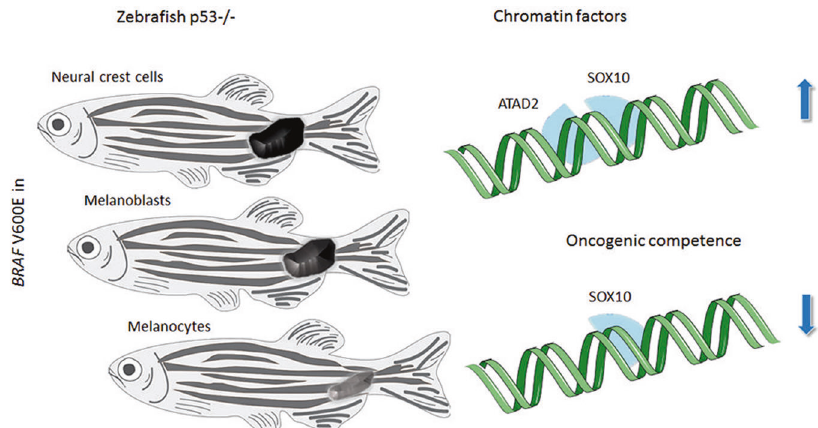
Fig. 1 Oncogenic transformation of p53 − / − zebra fi sh results in melanoma formation when the melanoma oncogene BRAF V600E is expressed in neural crest cells or melanoblasts but not when expressed in melanocytes. Epigenetic analyses showed that ATAD2 – SOX10 interaction